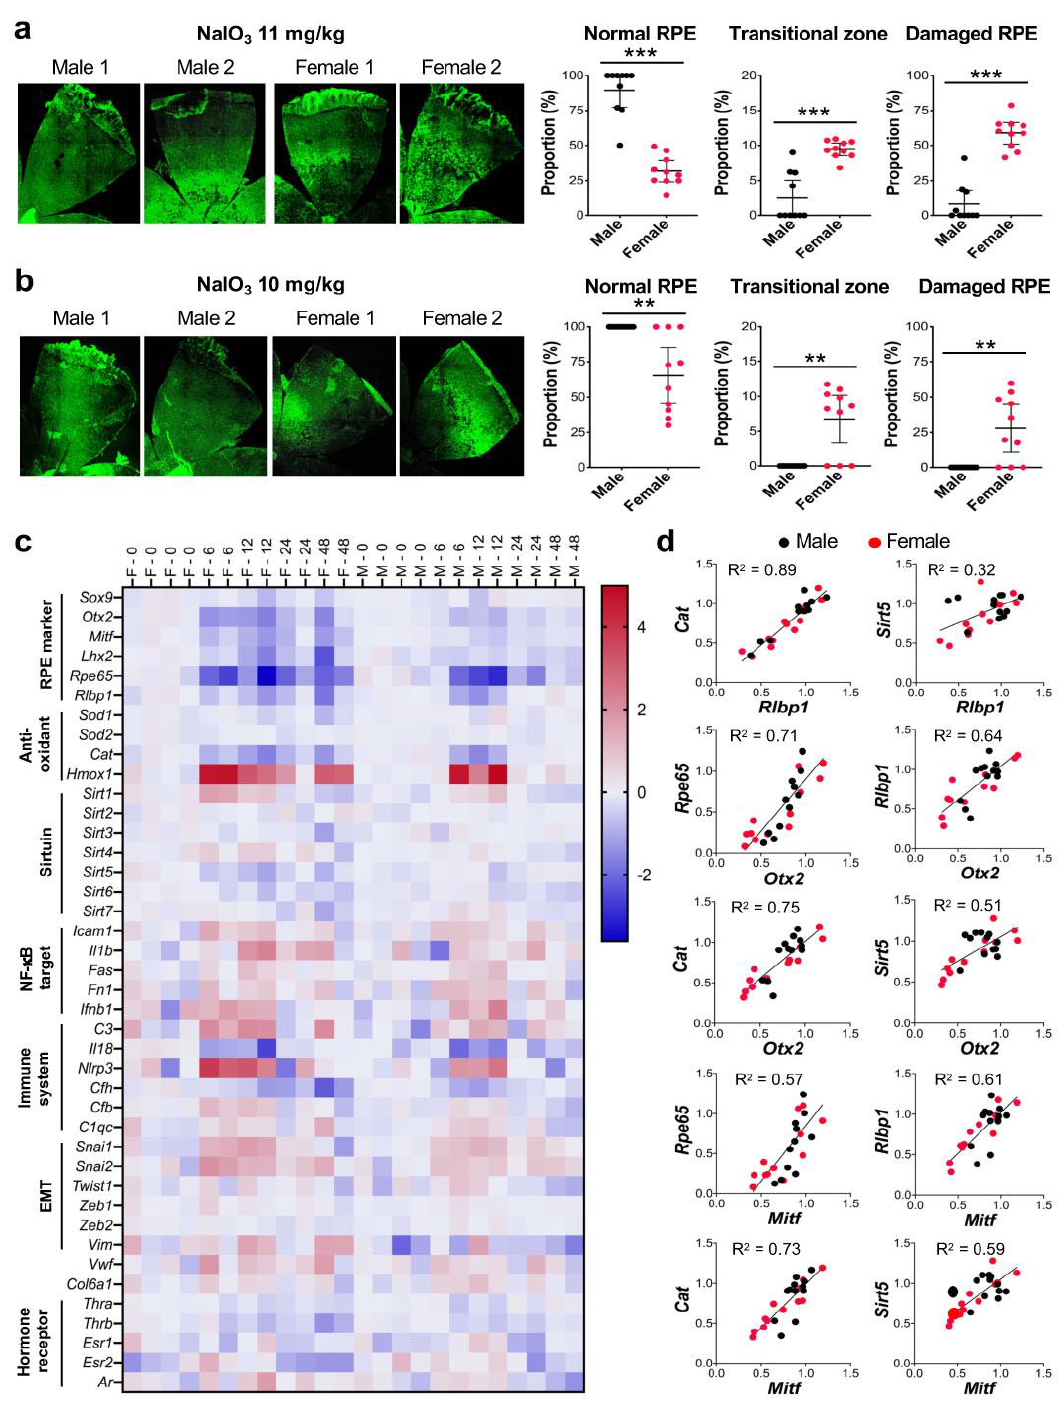
Figure 3. The RPE is more susceptible to NaIO 3 in female mice than in male mice. ( a , b ) Sex-specific differences in the degree of RPE damage caused by NaIO 3 in mice. Male and female C57BL/6J mice were injected with NaIO 3 at 11 mg/kg BW ( a ) and 10 mg/kg BW ( b ) via tail vein and analyzed 7 days later, as described in Figure 1. On the left, two representative images of RPE flat-mounts with ZO-1 immunofluorescence (green) are shown for male and female mice with each dose. On the right, the quantification results of all mice in each group are shown. The proportions (%) of the three regions, normal RPE (periphery), elongated RPE (transitional zone), and damaged RPE (center), were calculated compared to the entire RPE. The values represent the means (horizontal lines) and 95% confidence intervals (error bars). The values were compared between male and female mice, and statistical significance was determined by Student’s t test (unpaired, two-tailed), which is shown